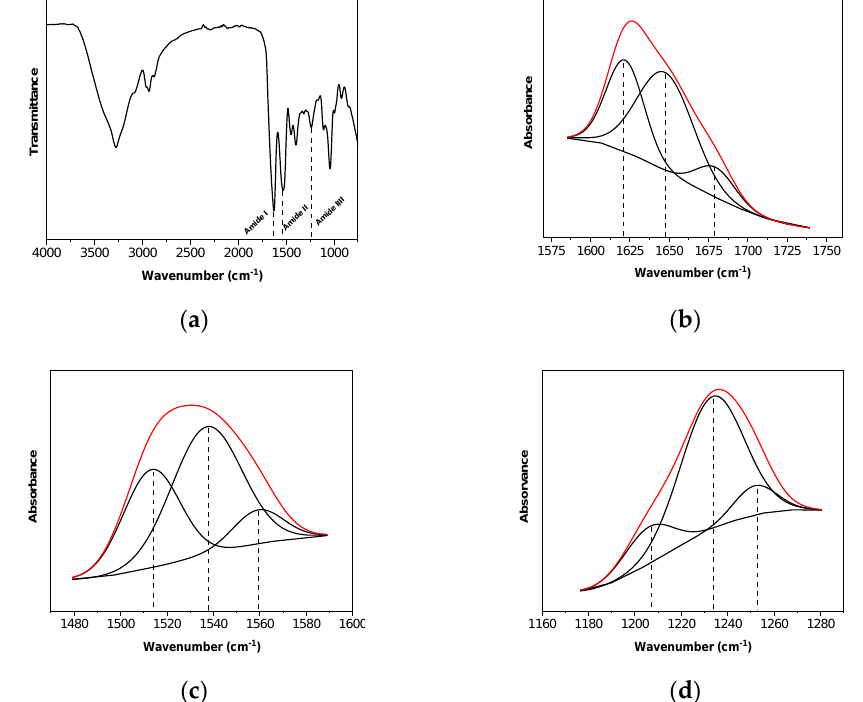
Figure 3. ( a ) FTIR spectrum and curve fitting of ( b ) amide I, ( c ) amide II, and ( d ) amide III of SPI films. Table 1. Secondary structure determination for amide I, II and III in SPI films. FTIR Band